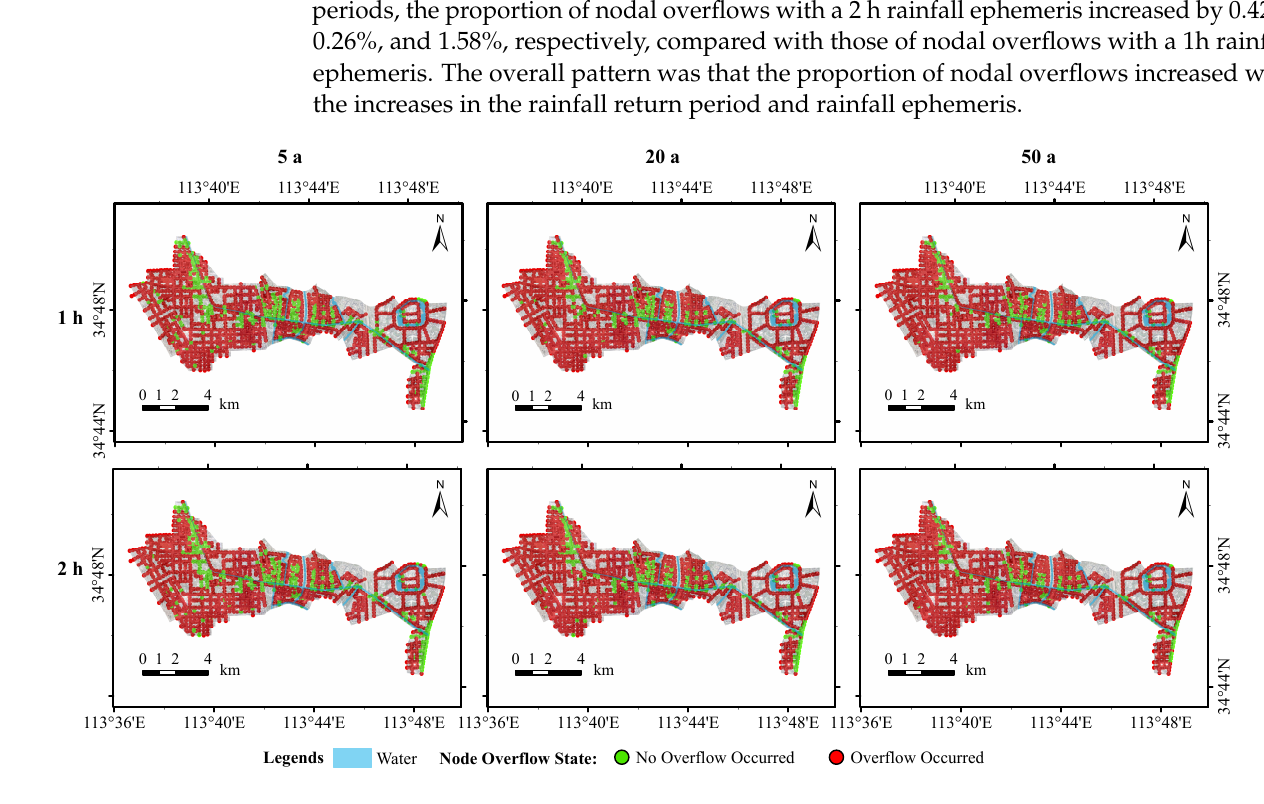
Figure 8. Simulated node overflow condition diagram. Table 4. Overflow statistics for different scenario